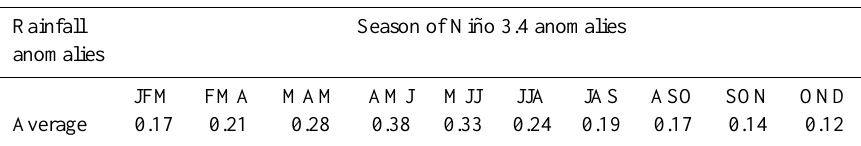
Table 2. Coefficient of determination ( R 2 ) for the linear fit between Niño 3.4 in different seasons and the JJAS averaged simulated rainfall anomalies at the upper catchment of the Blue Nile for the period 1982–2009.